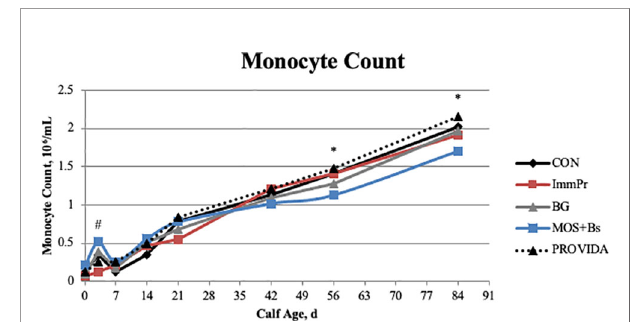
FIGURE 6 | The monocyte count was measured on d 0, 3, 7, 14, 21, 42, 56, and 84. There was a treatment x time interaction ( P ≤ 0.006). The MOS+Bs treatment had decreased monocytes when compared to other treatments; MOS+Bs vs. CON ( P ≤ 0.007) on d 56, and 84; MOS+Bs vs. ImmPr ( P ≤ 0.085) on d 3, 7, 56, and 84; MOS+Bs vs. BG ( P = 0.033) on d 84; MOS+Bs vs. PROVIDA ( P ≤ 0.077) on d 3, 56, and 84. Largest SEM per time point are expressed as 10 6 /mL and include 0.045, 0.109, 0.075, 0.129, 0.112, 0.066, 0.074, and 0.089 for d 0, 3, 7, 14, 21, 42, 56, and 84, respectively. An * indicates a treatment difference of ( P ≤ 0.05) and a # indicates a tendency for a treatment difference (0.05 < P ≤ 0.10) when treatments were sliced by time.